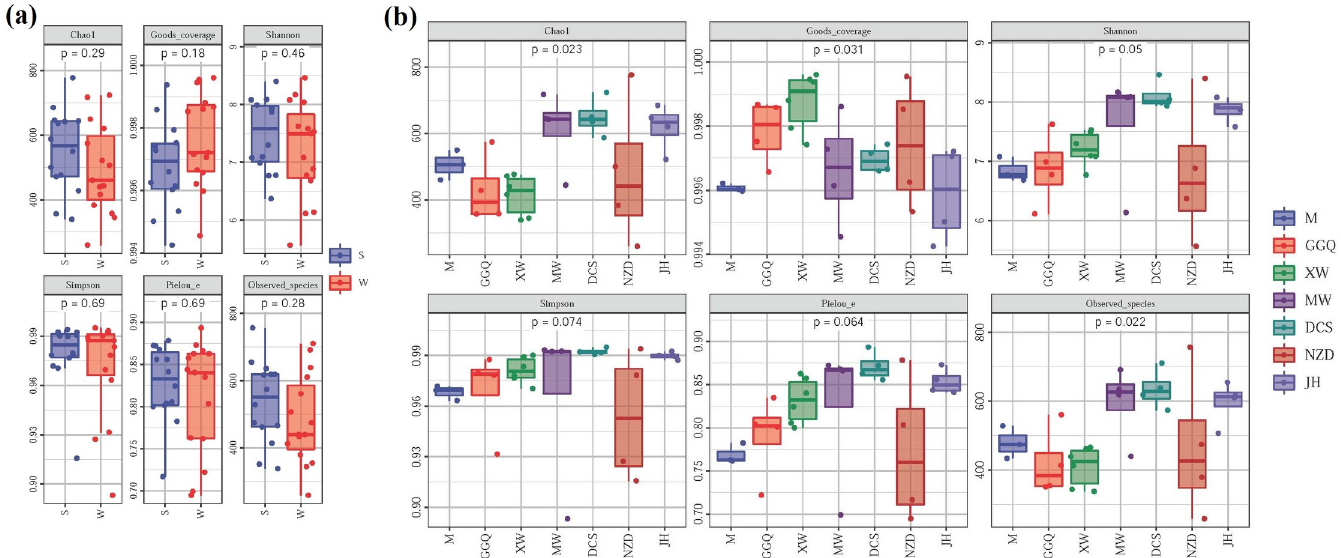
Fig 3. Archaeal community richness and diversity of LRCR in different seasons (a) and reservoirs (b).